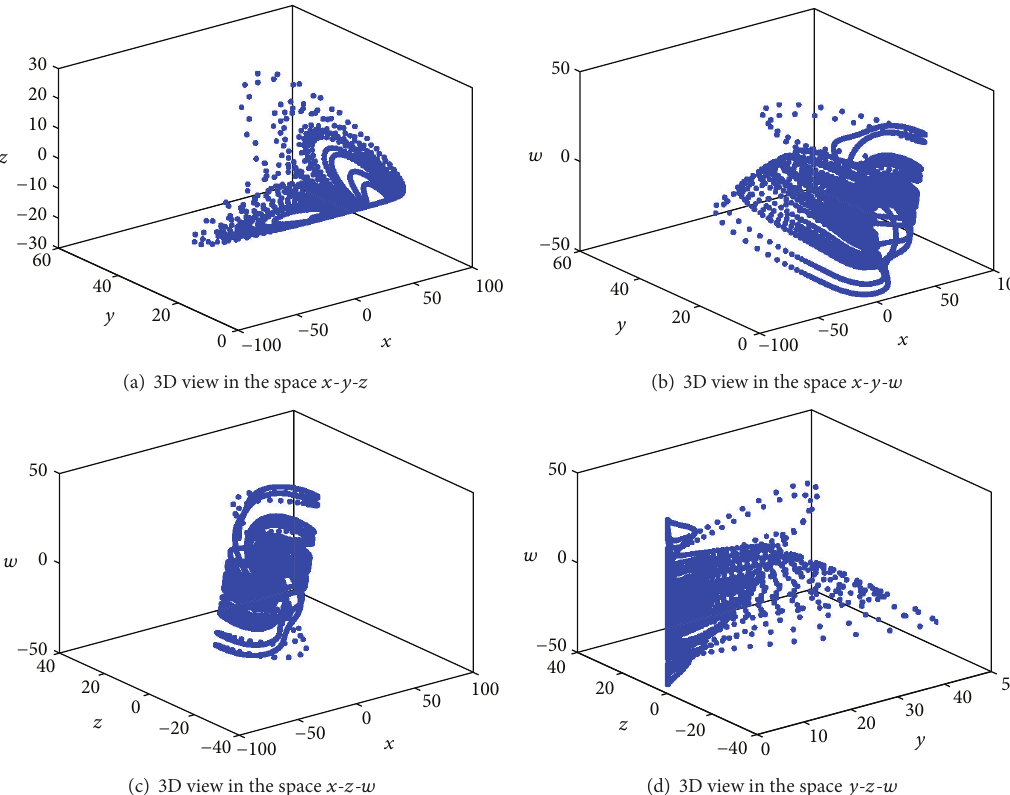
Figure 6: Hyperchaotic attractors.